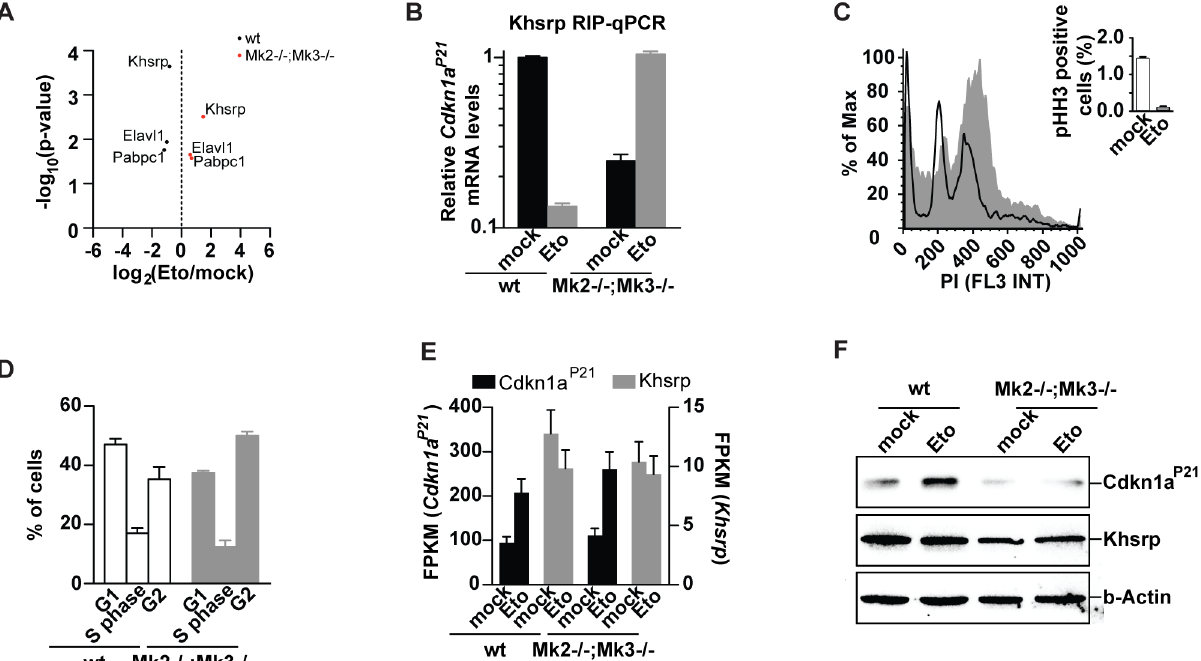
Fig 4. Mk2/3-dependent regulation of Khsrp and Cdkn1a p21 . (A) Mk2 -/- ;Mk3 -/- cells show a differential protein-RNA interactome in response to etoposide exposure when compared to wildtype cells (most-significant changes are highlighted). (B) Khsrp RNA immunoprecipitations (RIP) followed by Cdkn1a P21 qPCR validates interactome changes seen in wildtype and Mk2 -/- ;Mk3 -/- cells upon etoposide treatment. Upon etoposide exposure Khsrp is released from Cdkn1a P21 transcripts. In contrast, in Mk2 -/- ;Mk3 -/- MEFs, Khsrp-bound Cdkn1a P21 transcripts increase upon etoposide exposure. (C) Despite a typical arrest in G 2 upon etoposide treatment, (D) Mk2 -/- ;Mk3 -/- MEFs show a decreased G 1 population in comparison to wt cells. (E) Increased levels of the Cdkn1a P21 transcript in Mk2 -/- ;Mk3 -/- cells upon etoposide treatment (F) fail to promote the upregulation of Cdkn1a P21 protein levels seen in wildtype cells.